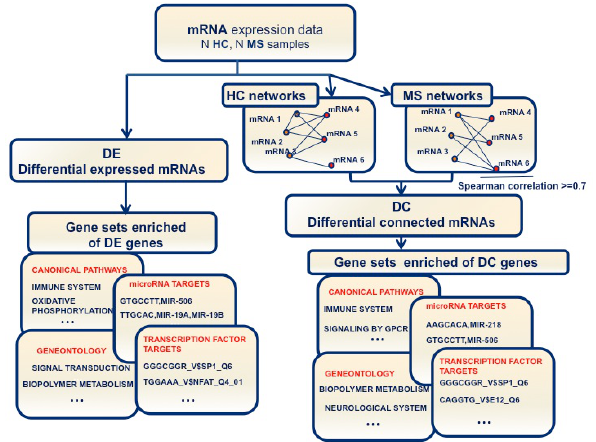
Figure 1. Bioinformatics workflow of the study. The picture refers to the MS vs. HC comparison. The same workflow was adopted to analyze datasets related to interferon (IFN)- β -treated and untreated MS patients.